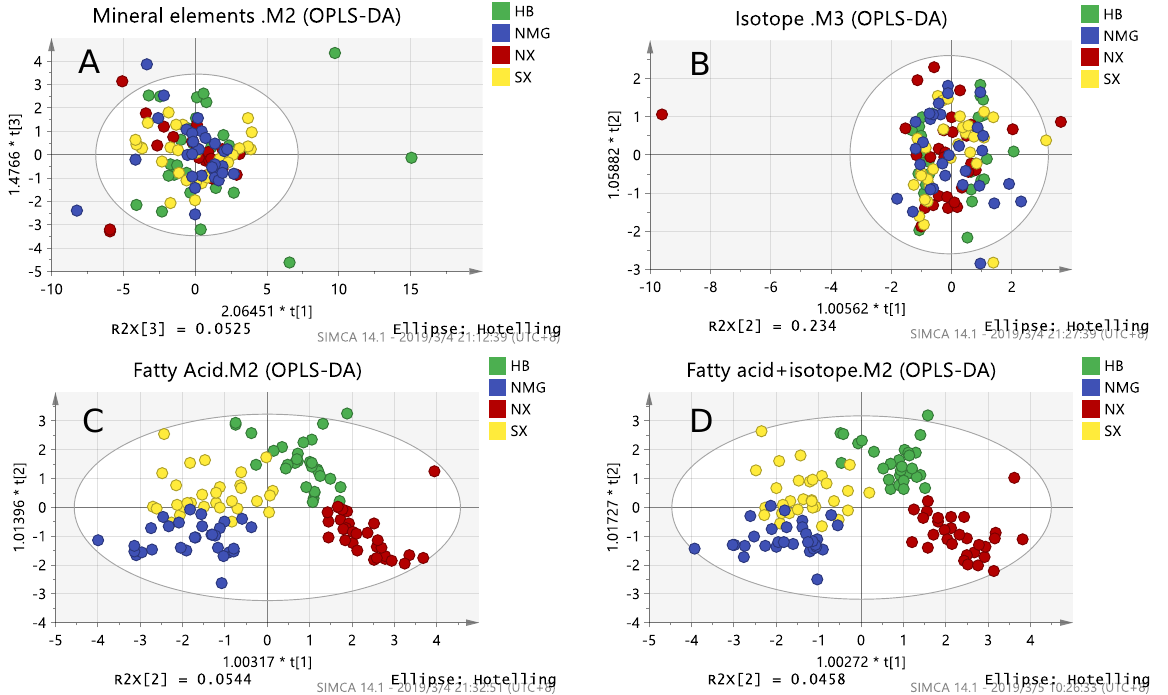
Figure 1. OPLS-DA score plots of inter-provincial samples obtained by a chemical analysis of: ( A ) Mineral elements; ( B ) Isotopes; ( C ) Fatty acids; ( D ) Fatty acids combined with isotopes.